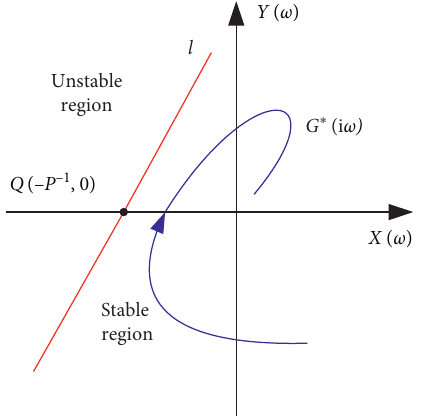
Figure 7: Relationship between Popov line l and frequency characteristic